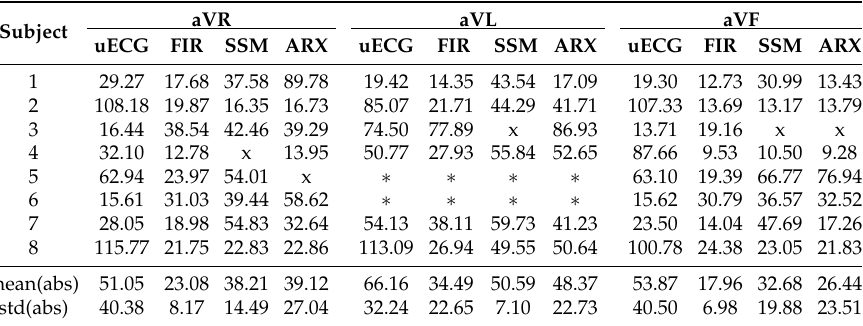
Figure 8. Example estimation of reference ECG ( a ) Coherence estimate of reference vs. uECG; and reference vs. estimated ECGs ( b ) Cross-spectrum Phase of reference vs. uECG, and reference vs. estimated ECG: (subject 1, aVF). Table 5. Mean of absolute cross-spectrum phase values (0–40